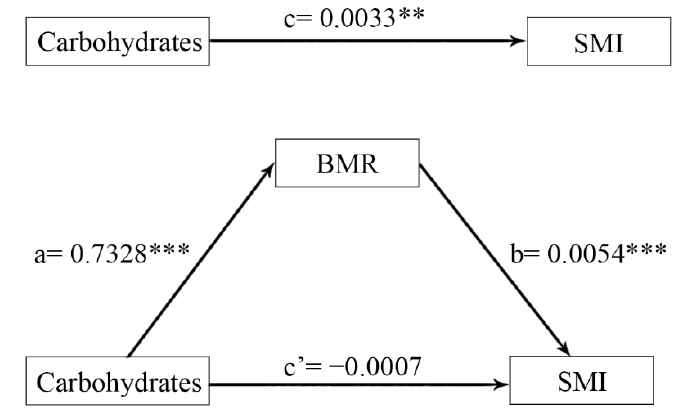
Figure 2. Mediating effect diagram for carbohydrates, BMR, and SMI while controlling for age. a × b: Indirect effect; c: total effect; c’: direct effect; c = c’ + a × b. BMR, basal metabolic rate; SMI, appendic-